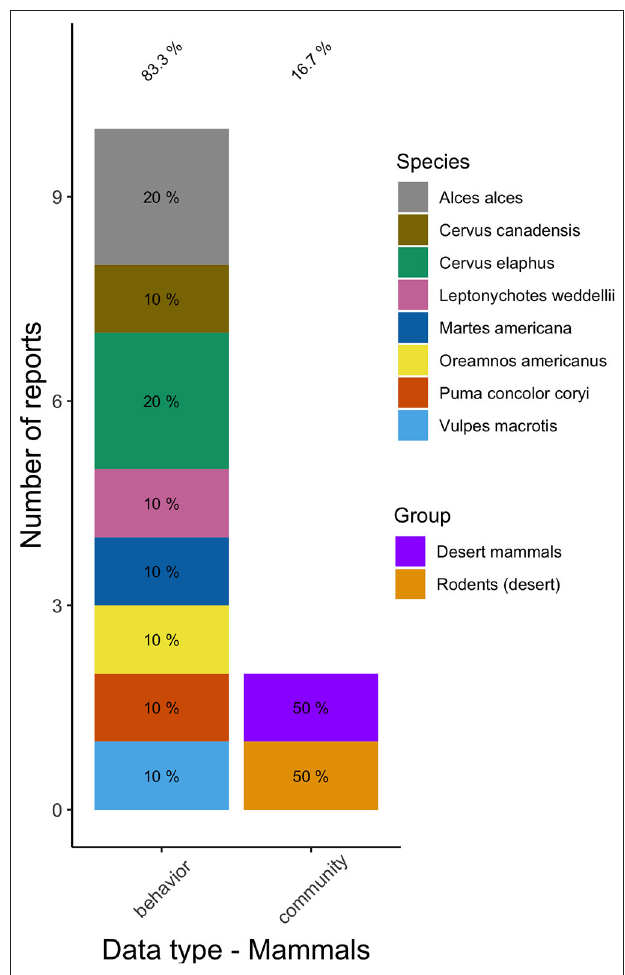
FIGURE 9 | Number of reports that accessed the impacts of off-road vehicle (ORV) use on mammals ( n = 12) across the type of data collected (behavior or community). Results are categorized by species or group of mammals that were